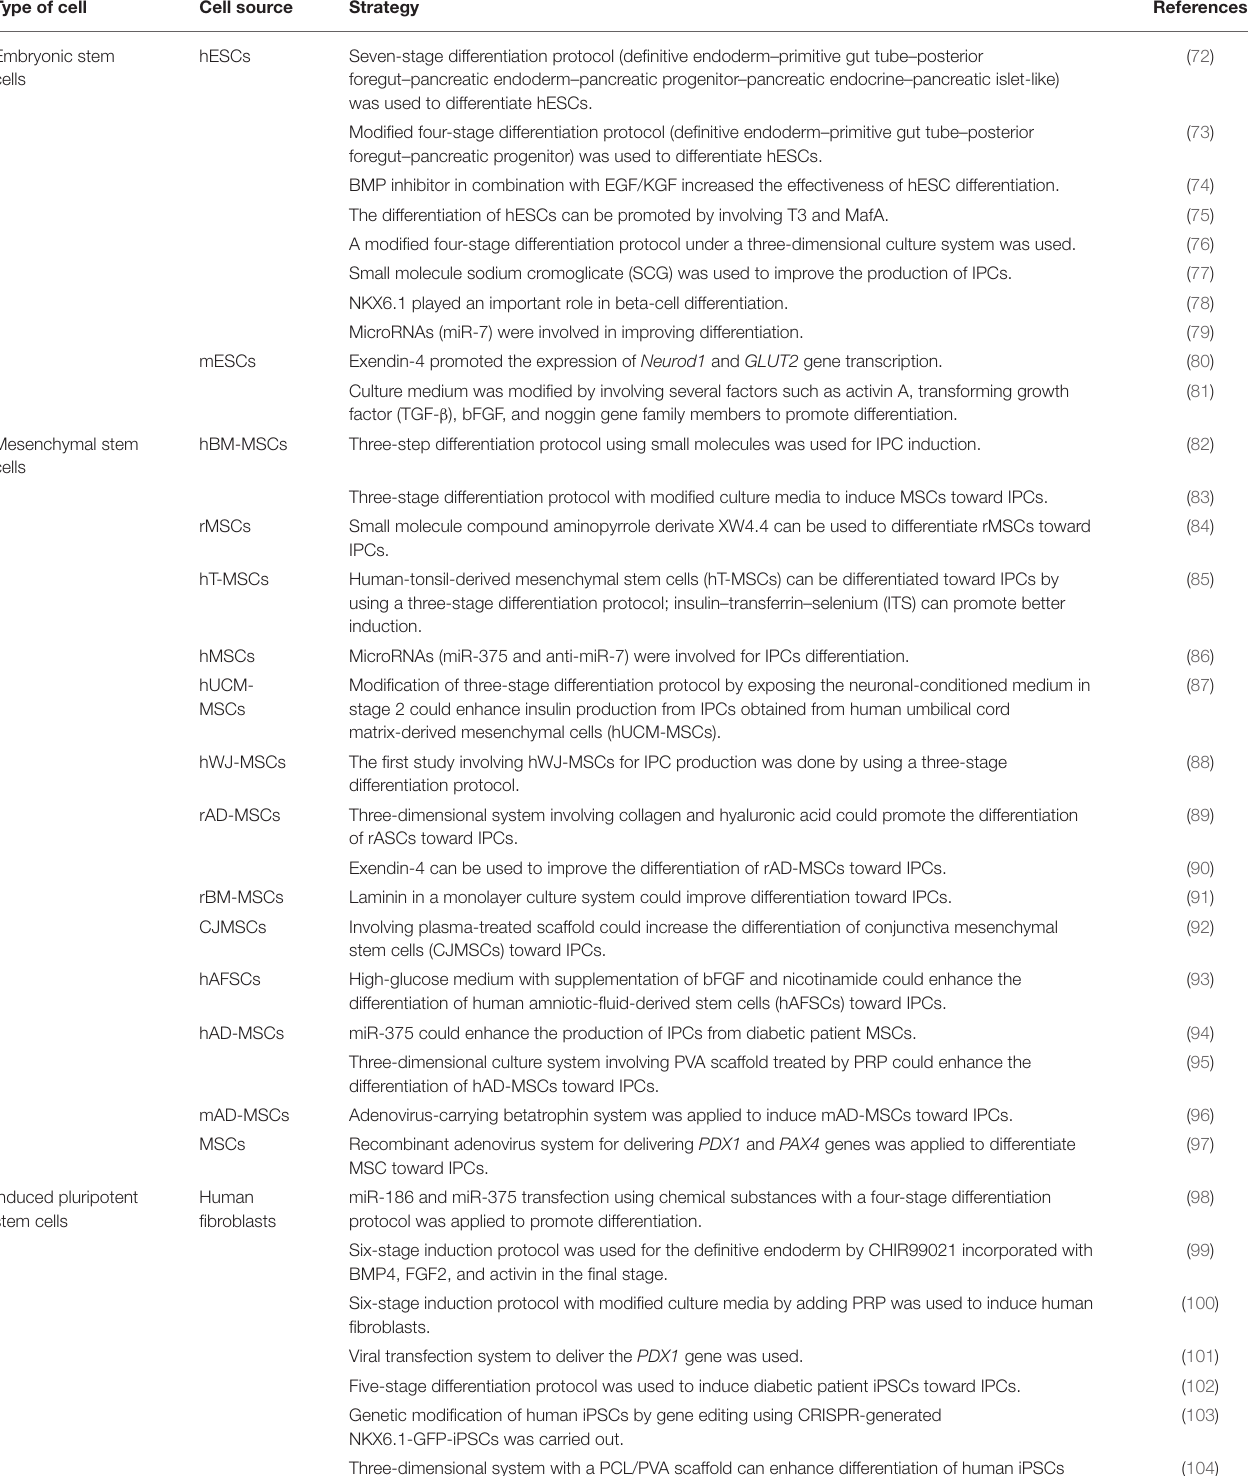
TABLE 3 | Strategy for generating insulin-producing cells (IPCs). Type of